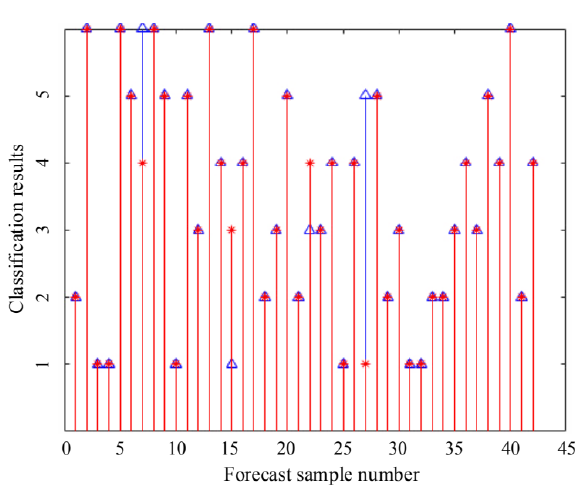
Fig. 9. Prediction effect diagram of fault diagnosis